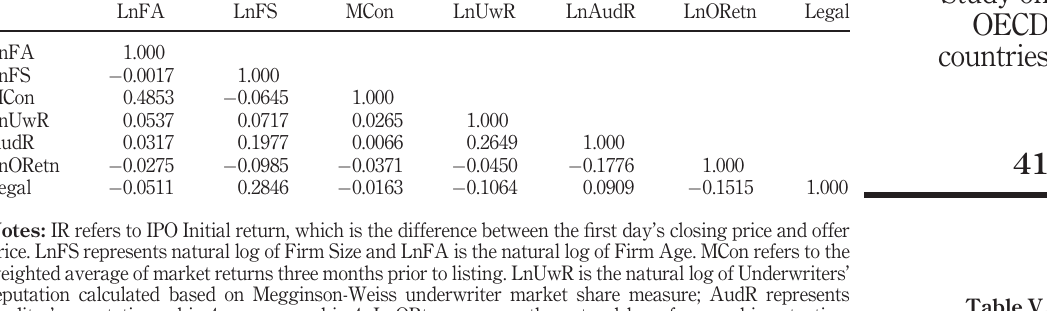
Table V. Correlation estimates